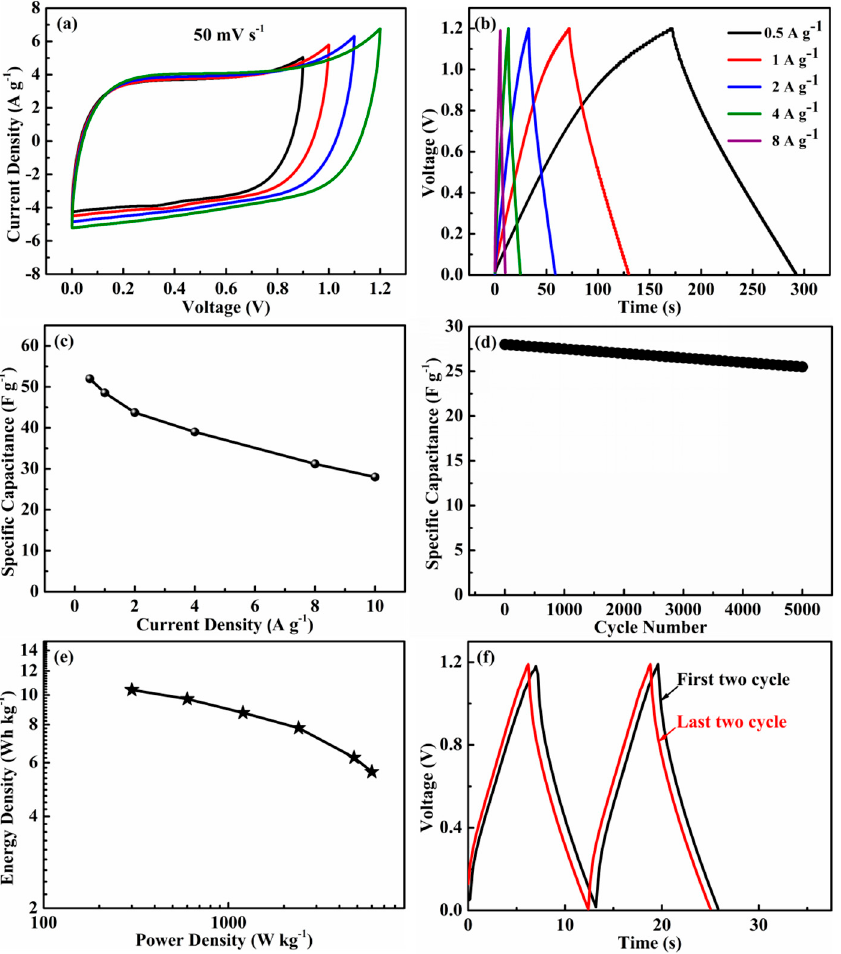
Figure 9. Electrochemical measurements of an as-assembled a-CSH-700//a-CSH-700 symmetric supercapacitor in a 6 M KOH electrolyte: ( a ) CV curves of the cell operated in different voltage windows at scan rate 50 mV/s; ( b ) galvanostatic charge/discharge curves of the cell at various current densities; and ( c ) specific capacitances for the supercapacitor at different current densities. ( d ) Cycling stabilities of the devices at a current density of 10 A/g. ( e ) Ragone plot. ( f ) First two cycle charge-discharge and last two charge-dischage plots.